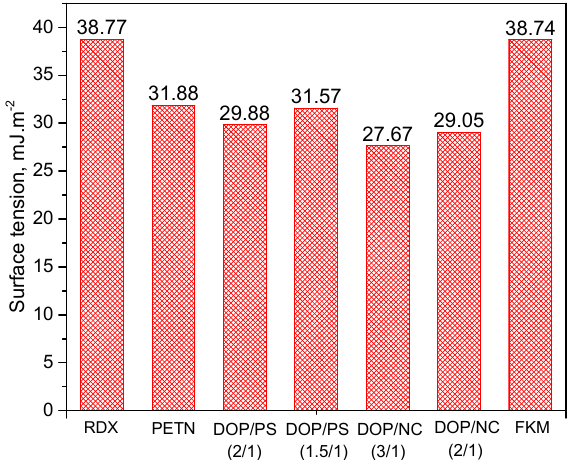
Figure 4. Surface tensions of energetic materials and several binders.